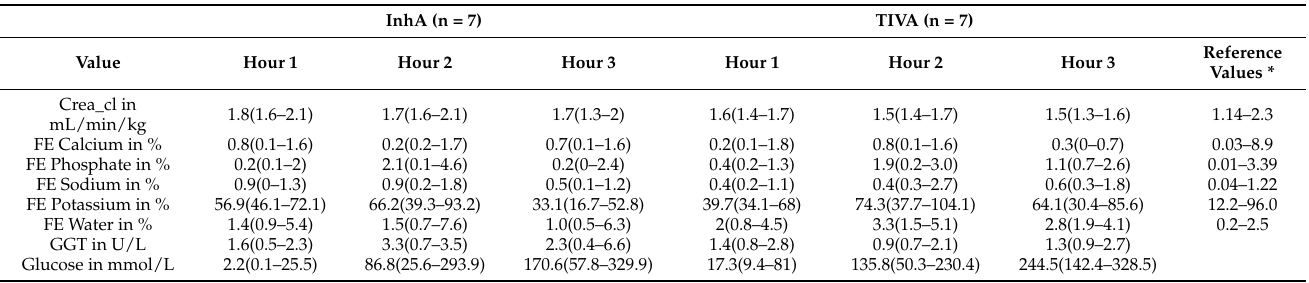
general anaesthesia for